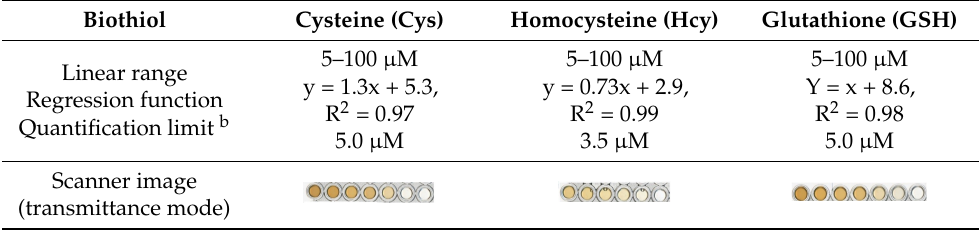
Table 1. Analytical figures of merit of the assay a .